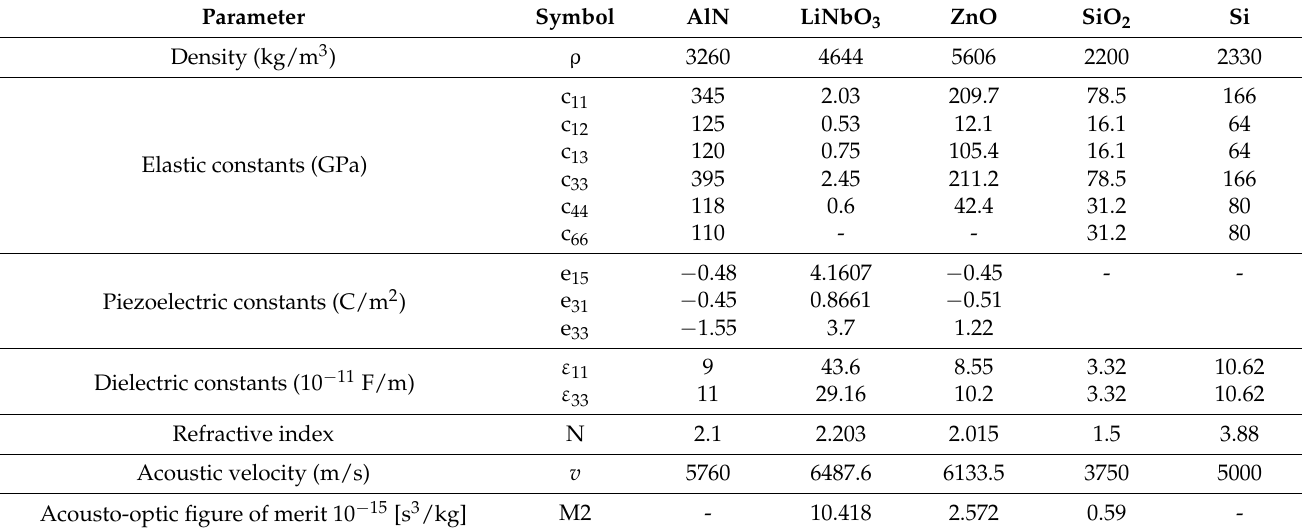
Table 3. Constants of materials used (AlN, LiNbO 3 , ZnO, SiO 2 and